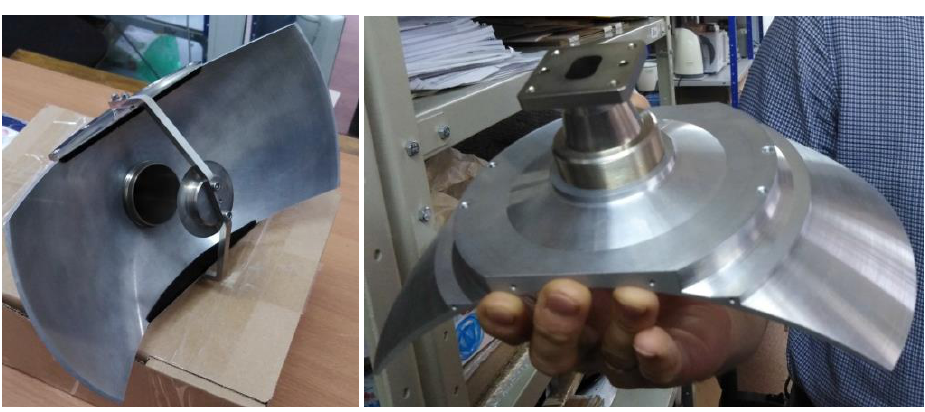
Fig. 2. X-band antenna design: aperture view (left), back side view (bottom). Table 2. Measured values of obtained technical characteristics of X- band antennas (polarisation